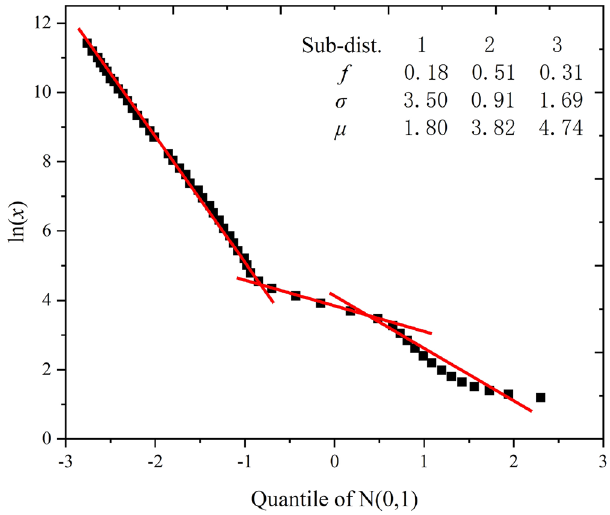
Figure 8. Initial prediction parameter acquisition method for the composite log-normal distribution.